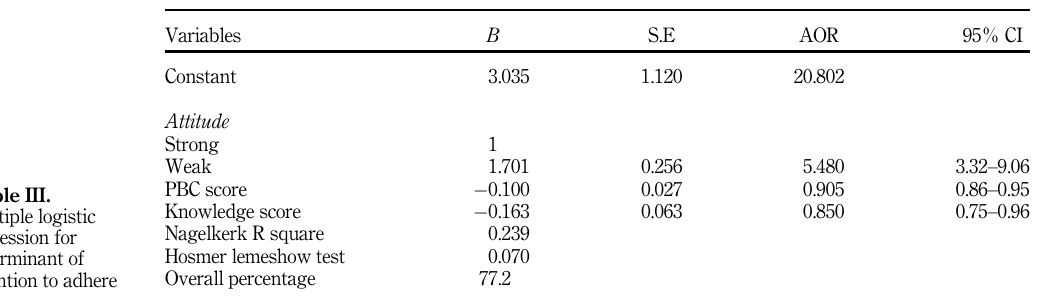
Table II. Bivariate analysis between study variables with intention to adhere